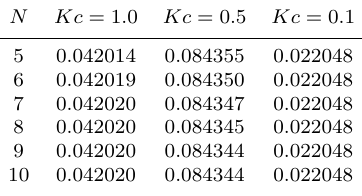
N Kc = 1 . 0 Kc = 0 . 5 Kc = 0 . 1